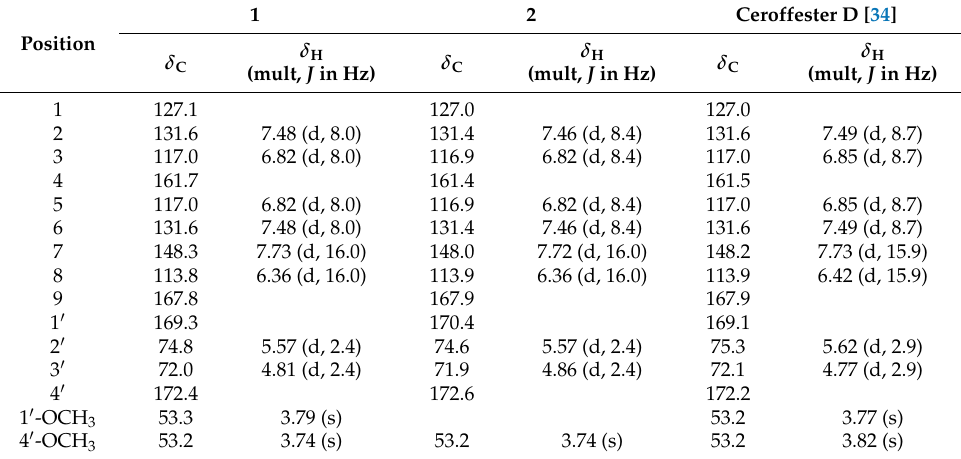
Table 3. 1 H and 13 C NMR data of compounds 1 , 2 and ceroffester D [a]